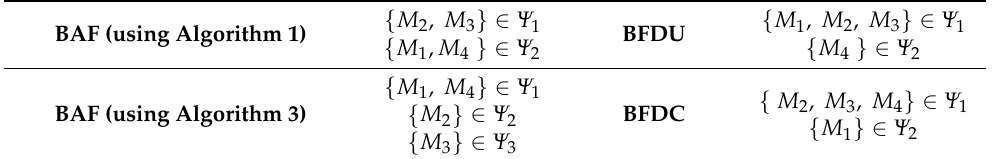
Table 5. Task Mapping Example